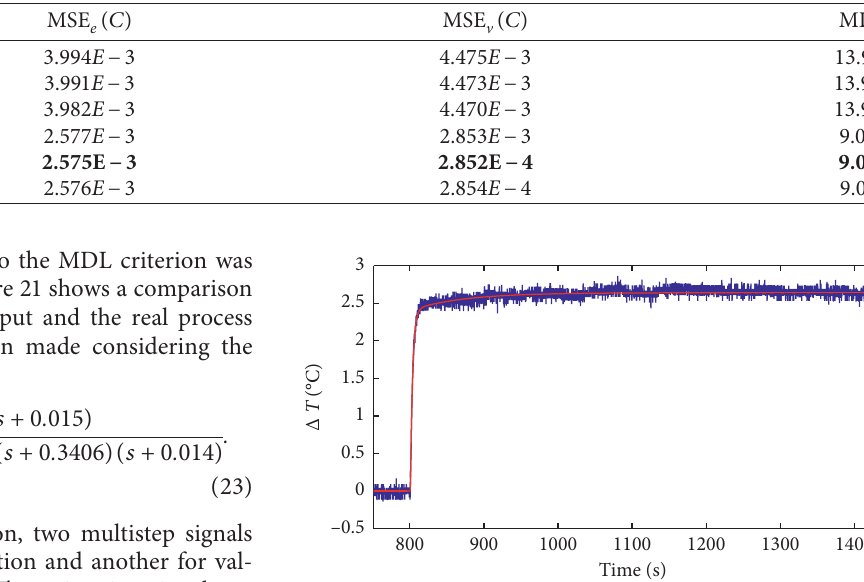
Figure 21: Comparison between the estimated model output (red) and the real process output